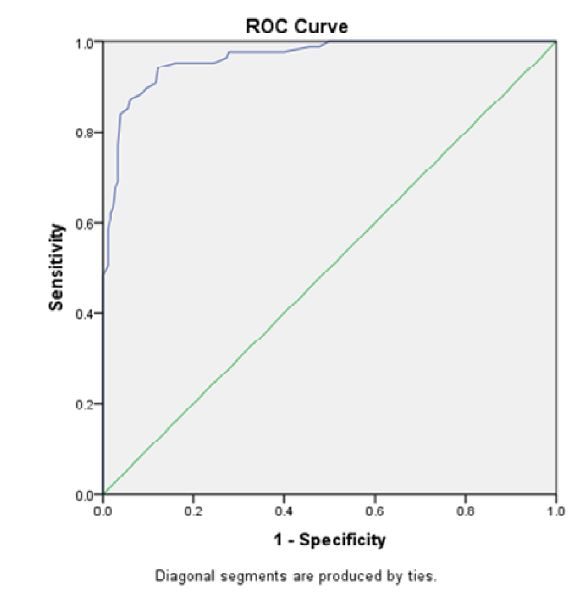
Figure 1. ROC curve for the total score of MBI- HSS against the clinical diagnosis of the